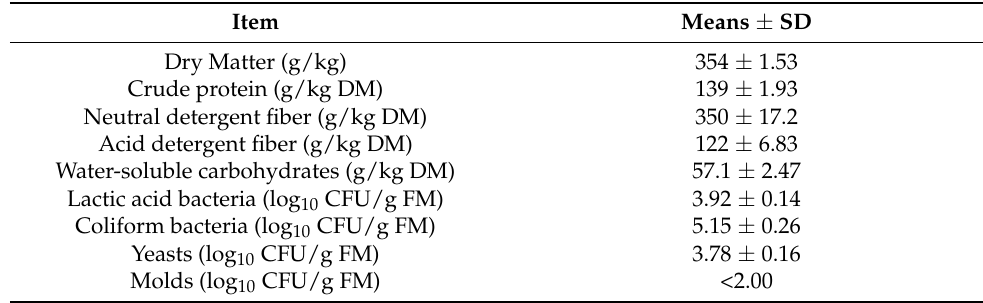
Table 1. Characterization of raw B. papyrifera leaves. Item Means ± SD Dry Matter